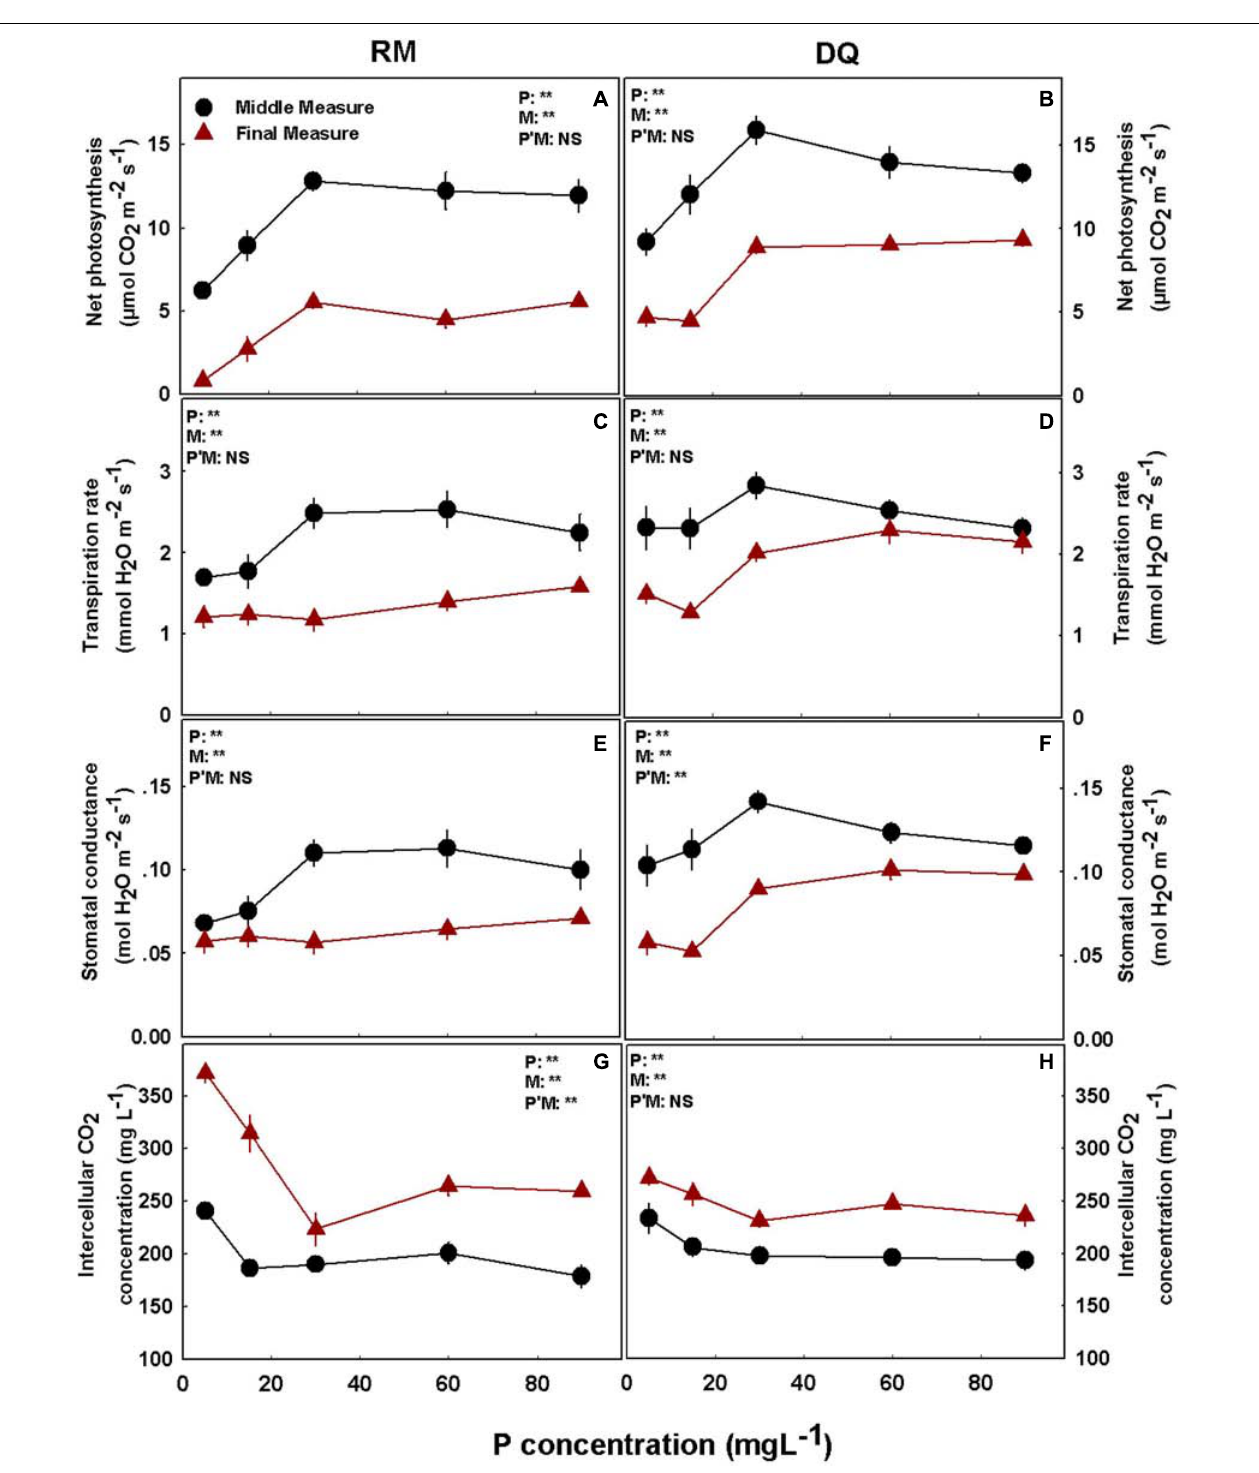
FIGURE 4 | Effect of P supply on gas exchange parameters in cannabis leaves. Net photosynthesis rate (A,B) , transpiration rate (C,D) , stomatal conductance (E,F) , and intercellular CO 2 (G,H) for two medical cannabis cultivars, RM and DQ. Results of measurements at two developmental stages, at the middle and at the end of the flowering phase. Presented data are averages ± SD ( n = 6). Results of two-way ANOVA indicated as ** P < 0.05, F -test; NS, not significant P > 0.05, F -test. In the ANOVA results, P*M, the interaction between P and